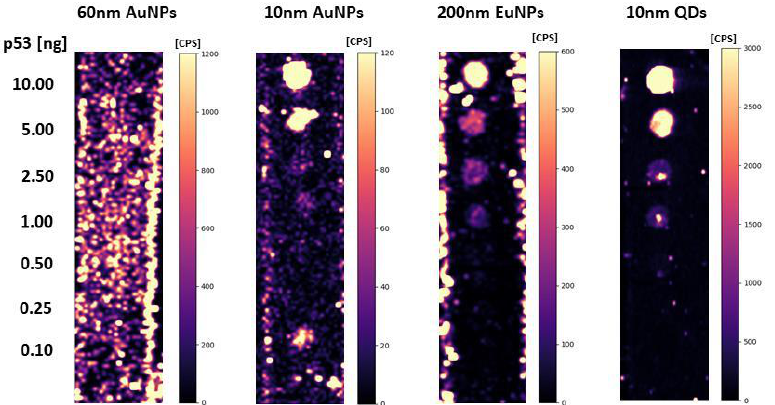
Figure 4. LA-ICP_MS dot-blot analysis of p53 protein standard (total protein amount 0.10–10.00 ng) using Au, Ag, Eu, and QD nanoparticles without antibody presence.